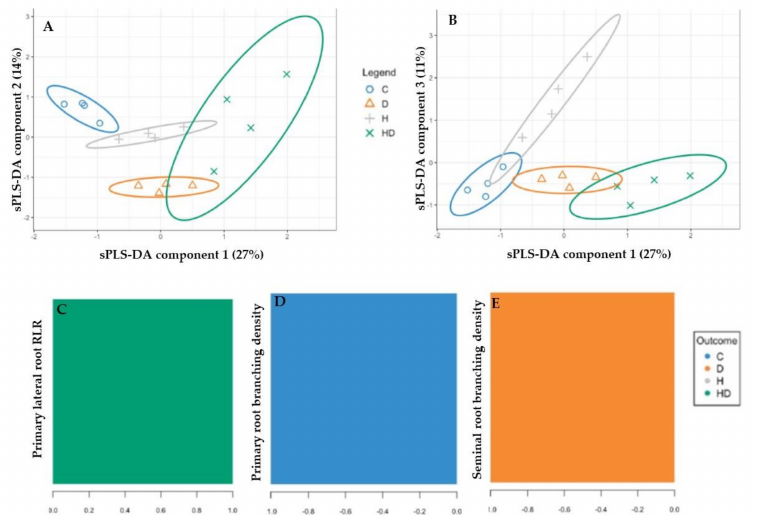
Figure 5. sPLS-DA sample plot for the different components using 95% confidence ellipses. ( A ) Com- ponent 1 vs. Component 2 and ( B ) Component 1 vs. Component 3. Contribution plots by loading weights of the root traits selected for each sPLS-DA component: ( C ) Component 1, ( D ) Component 2 and ( E ) Component